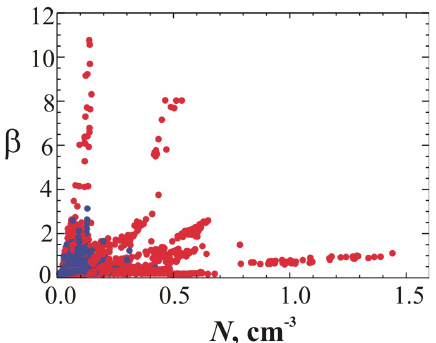
Fig. 7. Histograms of the distribution of the observation probability of the ion parallel dynamic pressure P high || , calculated for the high- energy part of the spectrum ( > 2keV) in the PSBL and the outer PS